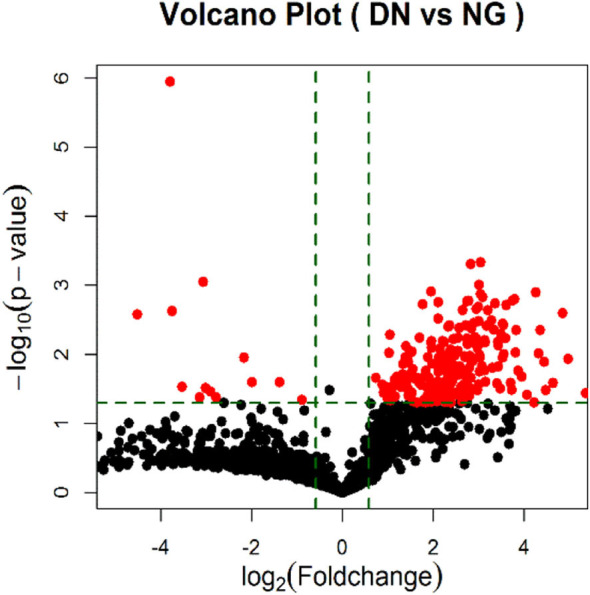
Volcano Plot of foldchange of differentially expressed miRNAs in DKD patients. Red and green colors represent fold change >2 and <2 (NG = DM patients; DN = type II diabetic kidney disease patients).